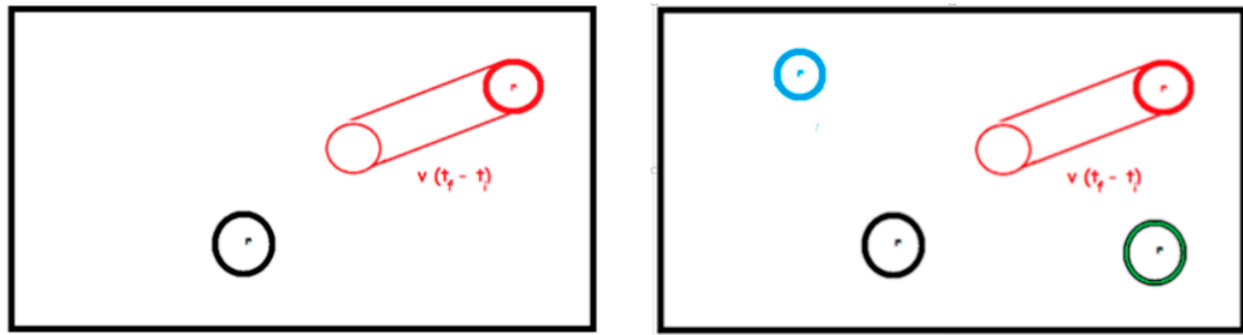
Figure 10. ( a ) Red ball moving at velocity v leaving a trace on the floor of the pool table. ( b ) Three balls at rest and one ball moving.